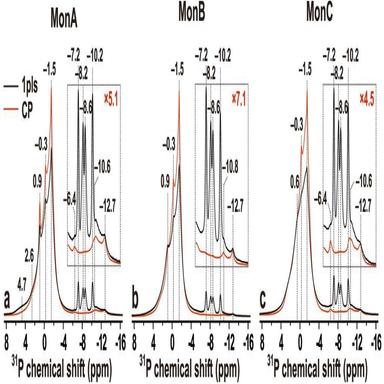
31P NMR spectra recorded at 14.00 kHz MAS from the (a) MonA, (b) MonB, and (c) MonC cements, as either excited directly by single pulses ("1pls"; black traces) or by transferring magnetization from nearby 1 H sites by 1 H→31P CP (red traces); all are normalized to the same integrated signal intensity ("constant area"). The inset spectra represent vertical expansions of the NMR intensities across the "pyrophosphate region", revealing resonances from both well-crystalline (narrow) and amorphous (broad) phases